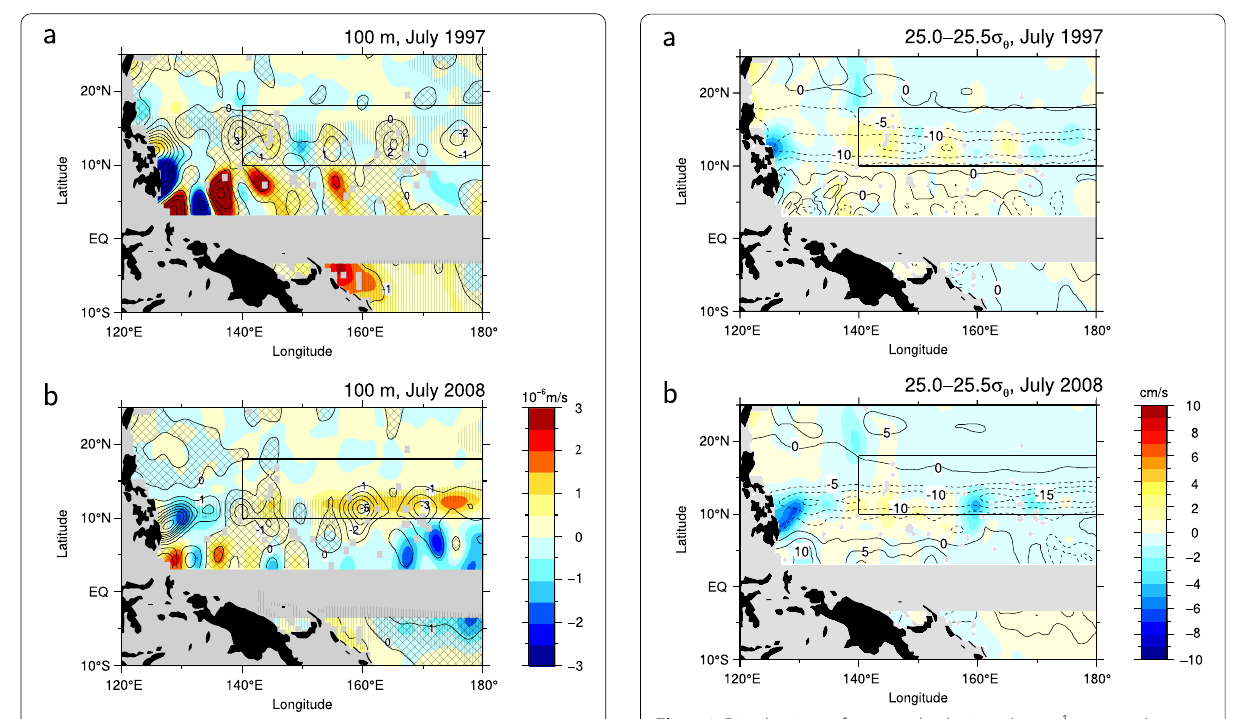
Fig. 15 Horizontal distributions of smoothed upward velocity w ( ms − 1 , color shading) and northward velocity v ( cms − 1 , contours) at a depth of 100 m in a July 1997 and b July 2008, i.e., periods of the weak and strong upward transports in Region A (solid square), which are denoted by upward and downward arrows in Fig. 14a, respectively. Data were smoothed by a 15-month running mean filter. Contour intervals of v are 1 cms − 1 and cross line meshing indicates northward velocity. Vertical line meshing illustrates the isopycnal zone of at a depth of 200 m